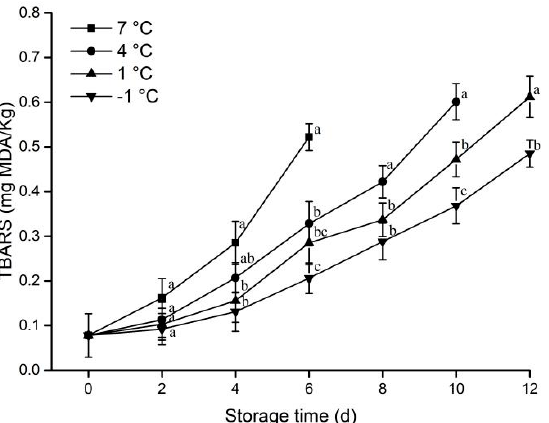
9 of 17 Figure 4. Effect of different storage temperatures on TAC of pork. Different lowercase letters (a − c) indicate significant difference ( p < 0.05) between each treatment on the same storage time . 3.1.5. Lipid Oxidation During storage, the barbiturate acid-reactive substances are produced by lipid oxi- dation in meat. The barbiturate acid-reactive substances can be used to reflect the degree